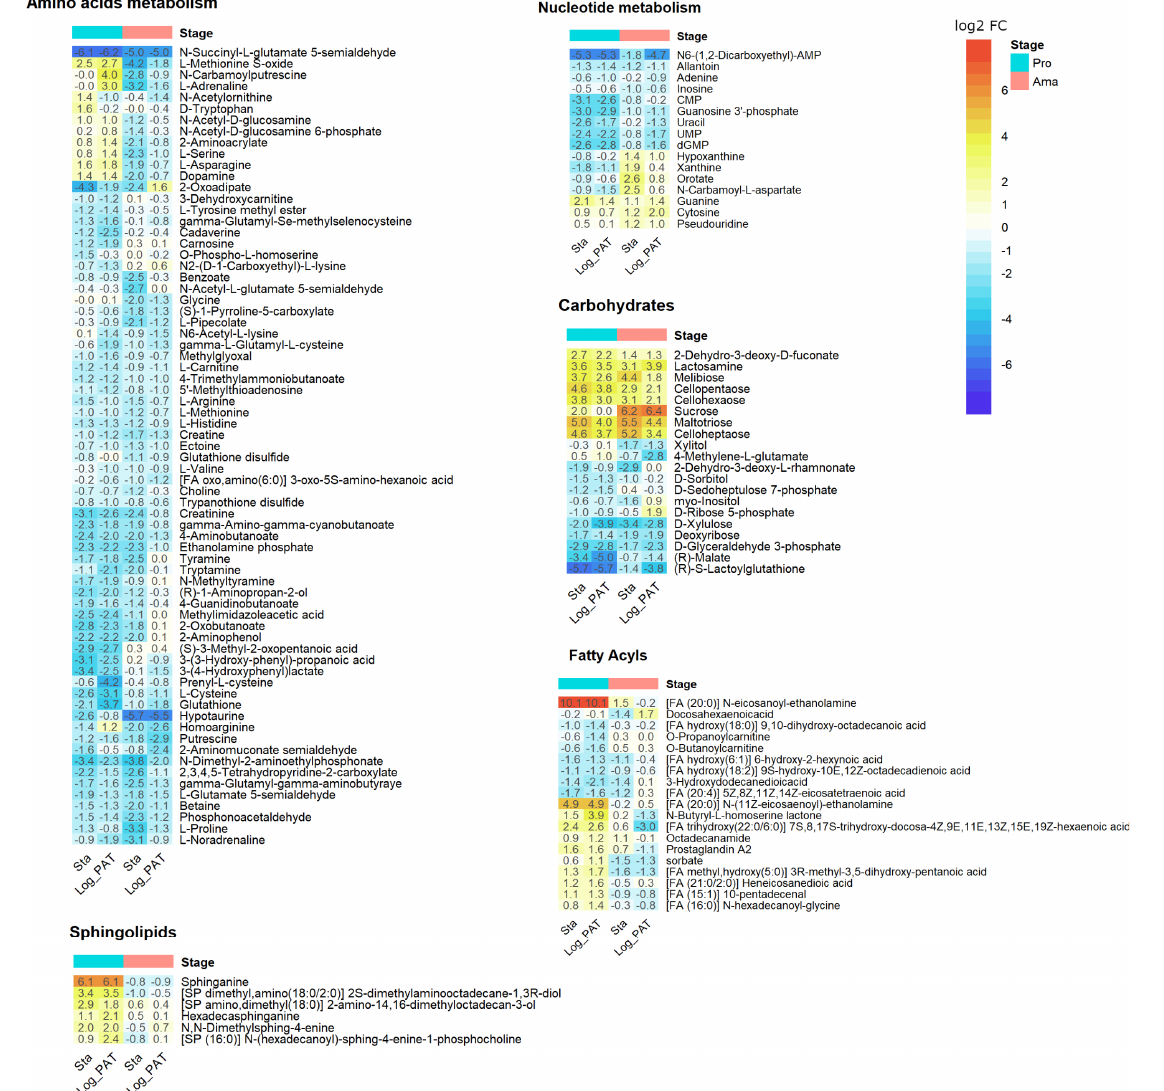
Figure 6. Main metabolic categories having metabolites with modulated abundance in quiescent cells induced by stationary or drug pressure, compared to proliferating cells. The numbers represent the log2 FC compared to condition Log (cell normalized dataset). Only metabolites for which at least one of the conditions has an |log2 FC| > 1 and a BH adjusted p < 0.05 are shown. Pro, promastigotes; Ama, amastigotes.